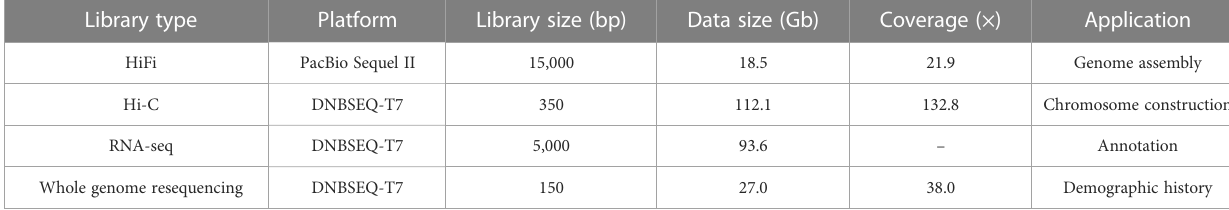
TABLE 1 Statistics of the sequencing data generated for O. cubicus genome assembly. Library